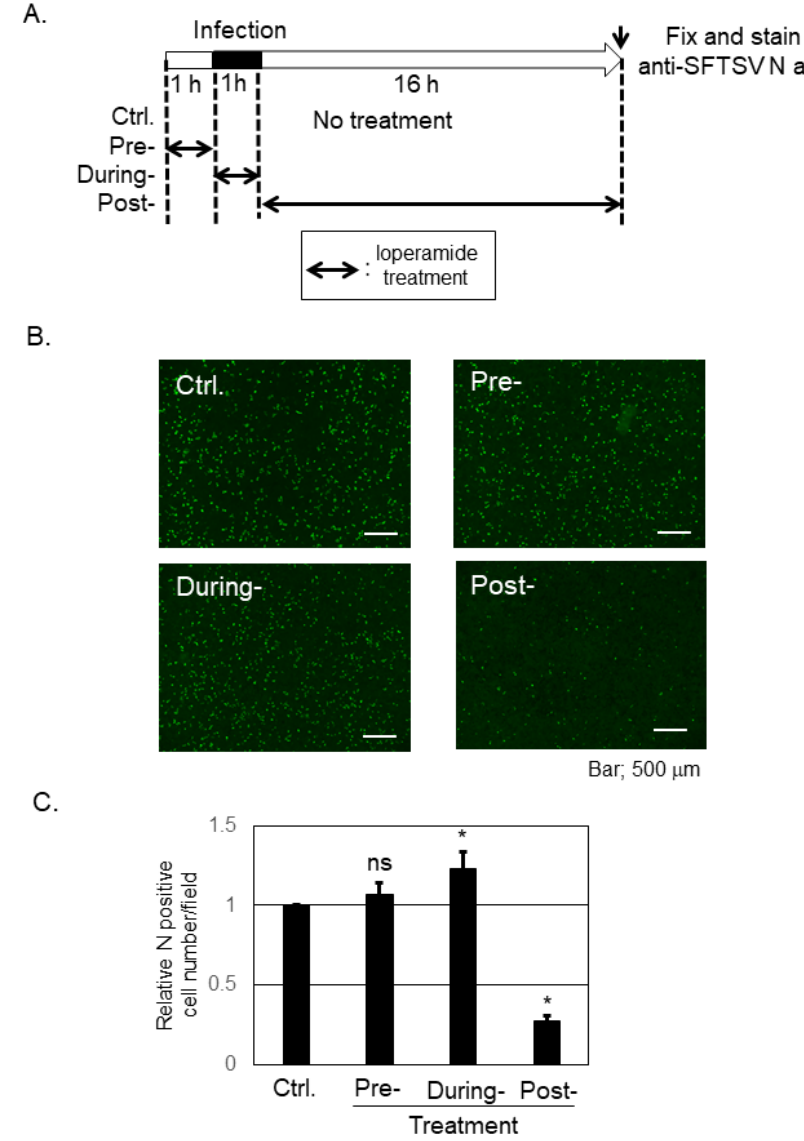
Figure 2. Loperamide affected the post-entry step, but not the pre- and during-entry steps, of the SFTSV infection. ( A ) Schematic representation of the time-of-addition infection assay, used to study the effect of loperamide on SFTSV infection. SFTSV was infected at an MOI of 1. ( B , C ) Loperamide-treated cells were fixed at 17 h p.i. (1 h for infection and 16 h for incubation) and stained with anti-SFTSV N antibody, followed by a secondary, FITC-conjugated anti-rabbit-IgG antibody. Images of stained cells were captured using a BZ-X700 microscope ( B ) and analyzed using the BZ-X analyzer software to automatically count the FITC-positive cell number in the fields. Four different fields were randomly selected from three independent wells to count the cells. Normalized FITC-positive cell numbers with control treatment were shown ( C ). Data correspond to the mean ± SD (ns; not significant, * p < 0.05).